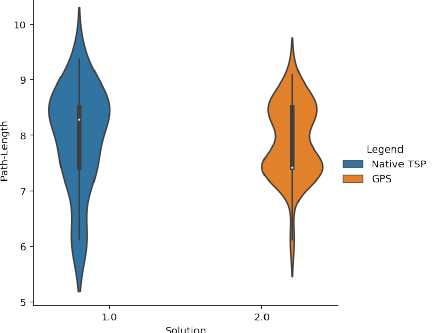
Figure 4. Path length comparison for N = 9. In this graph, we see how the length of the solution paths for the case of 9 Cities is very similar so that both models give good results.